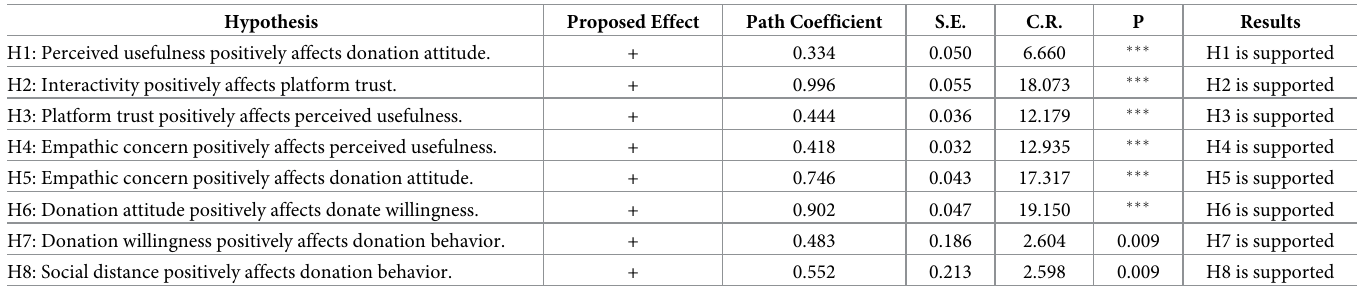
Table 7. Structural model results.